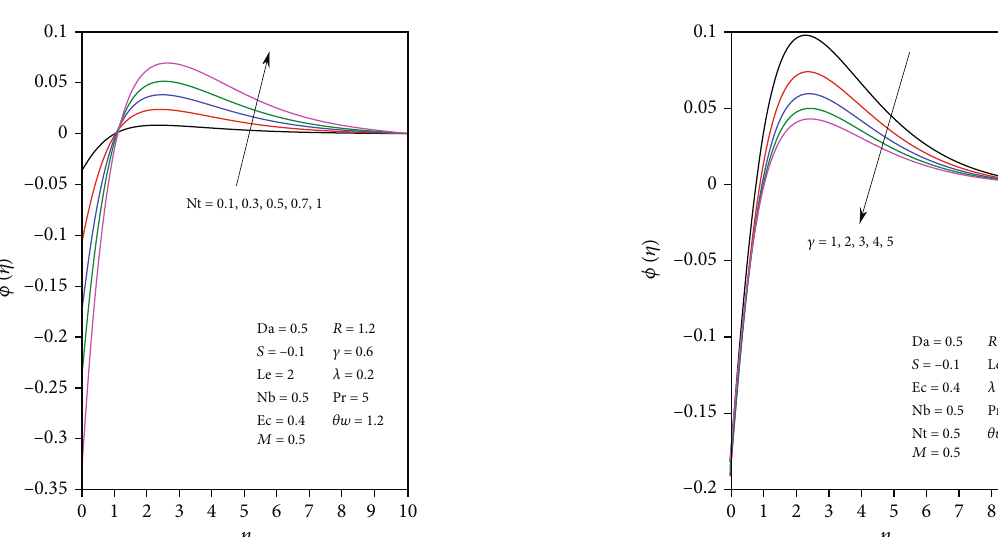
Figure 19: Concentration of nanoparticle pro fi le for di ff erent values of Nt .